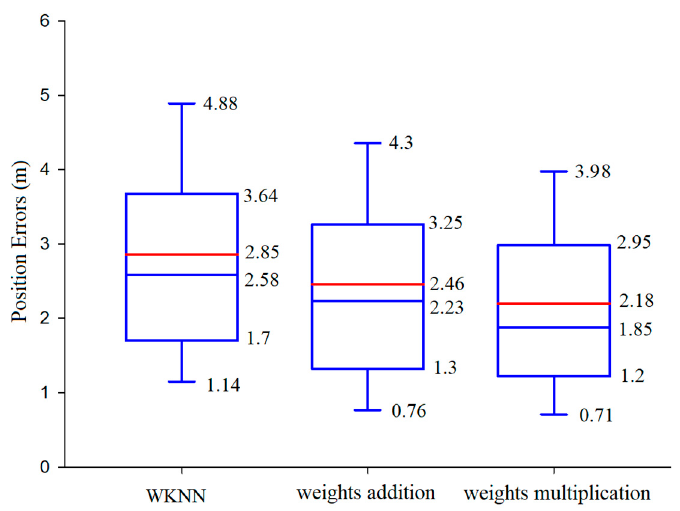
Figure 4. Comparison of the positioning performance represented by boxplots.